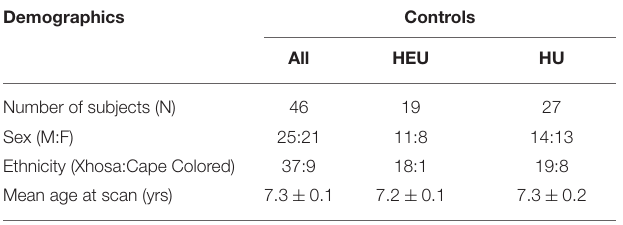
TABLE 1 | Sample characteristics of Controls (HEU, HIV exposed uninfected; HU, HIV unexposed uninfected) and the HIV + group (before-12wk, after-12wk). Demographics